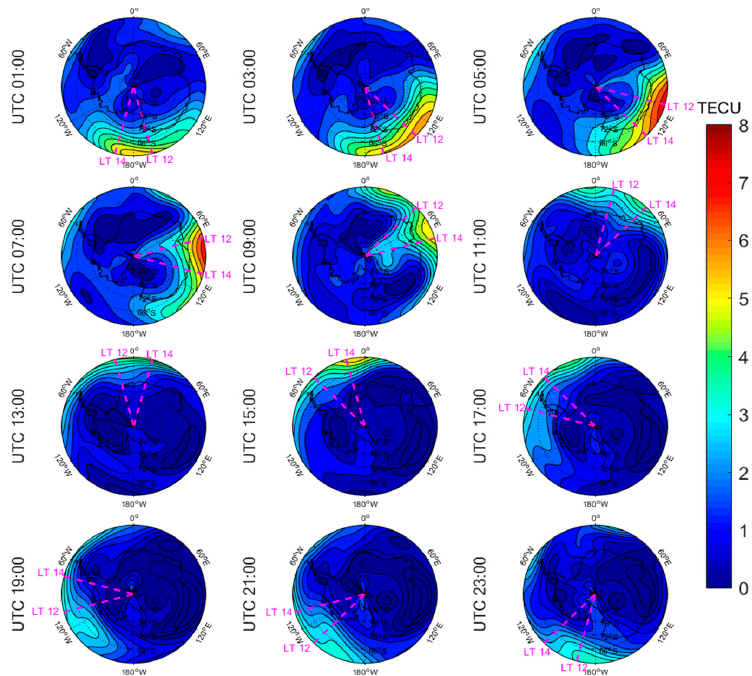
Figure 10. Spatial distribution of mapping TEC of 12 sections under low solar activity year, polar night (DOY 185 in 2010) over the Antarctic. The magenta lines in each subplot represent the longitudes at 12:00 and 14:00 at the middle of the 2 h section of the corresponding subplot.